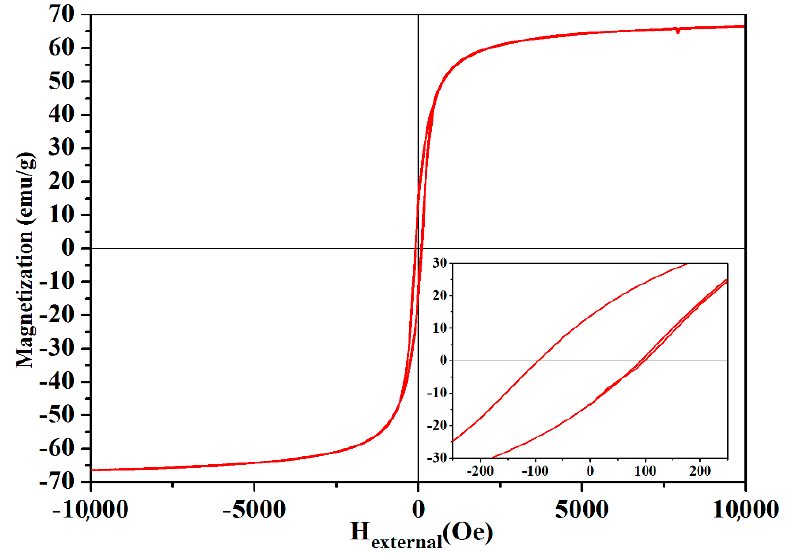
Figure 3. The magnetization curve (M-H) measured at room temperature for MIONPs; the inset shows a magnified view of the hysteresis loop.